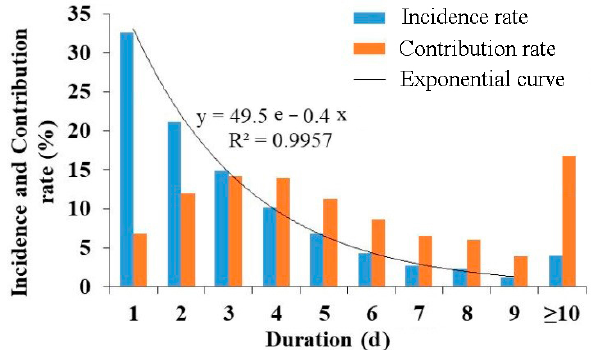
Figure 3. Incidence rate and contribution rate of different precipitation durations in the rainy season in the Beibu Gulf.